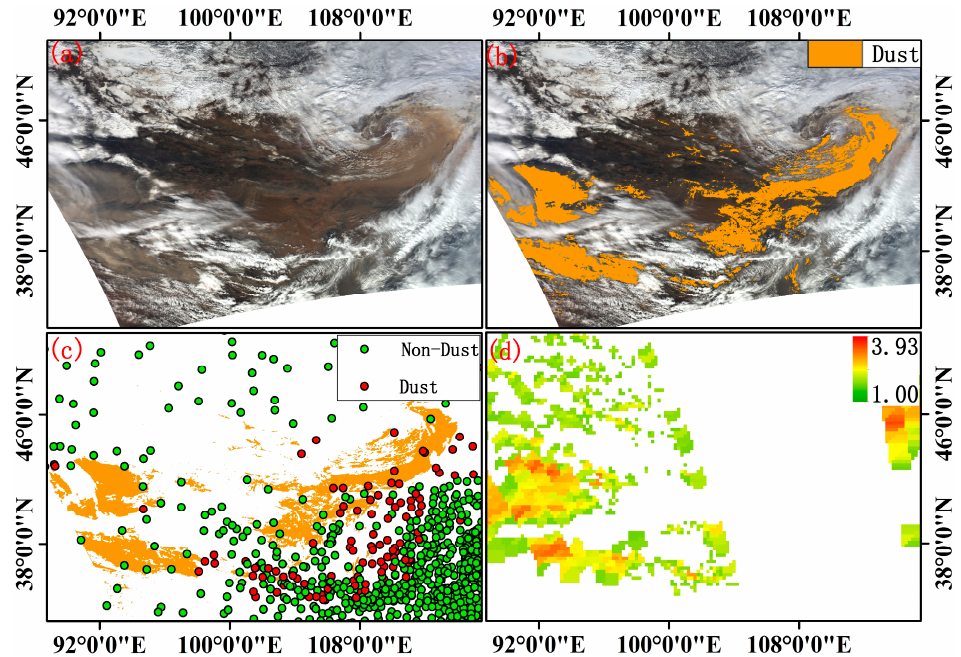
Figure 6. Comparison between the dust storm monitoring result (b), MODIS RGB image (a), MICAPS data (c), and OMI AI data (d) on 4 March, 2016. Remote Sens.2019, 5, x FOR PEER REVIEW